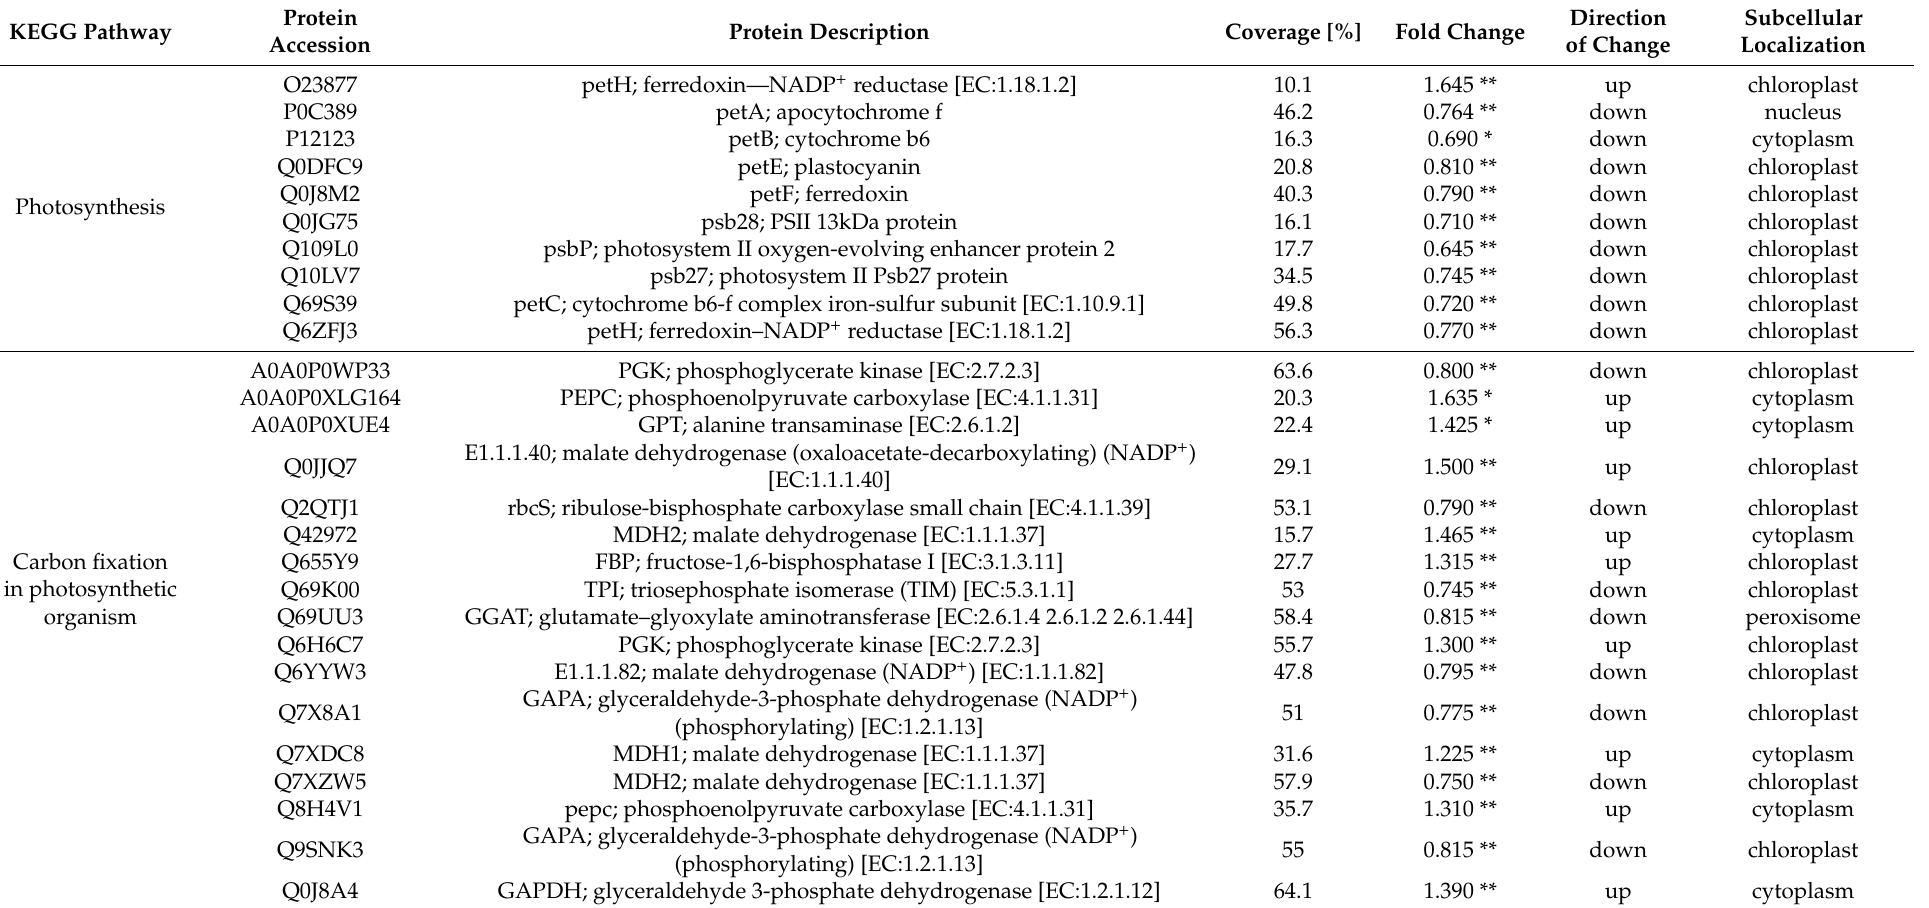
Table 3. Differential proteins associated with